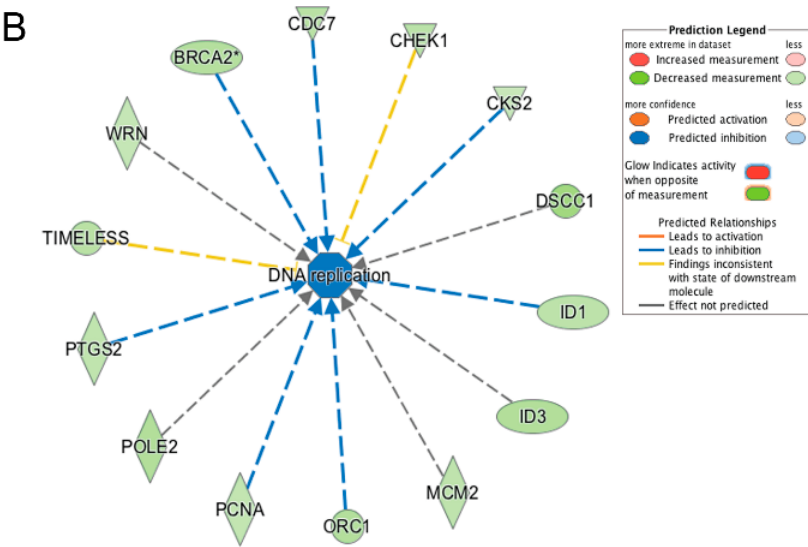
Figure 10. Ingenuity pathway analysis of differentially expressed genes unique to wildtype cells during transition from day 1 to day 2 of differentiation. ( A ) The top canonical pathway enriched from genes differentially expressed only in wildtype cells was the Cell Cycle: G2/M DNA Damage Checkpoint Regulation pathway. The network was generated through the use of IPA (Ingenuity Systems, www.ingenuity.com) on normalized mRNA values. Nodes represent molecules in a pathway, while the biological relationship between nodes is represented by a line (edge). Edges are supported by at least one reference in the Ingenuity Knowledge Base. The intensity of color in a node indicates the degree of up- (red) or down- (green) regulation. Nodes are displayed using shapes that represent the functional class of a gene product (Circle = Other, Nested Circle = Group or Complex, Rhombus = Peptidase, Square = Cytokine, Triangle = Kinase, Vertical ellipse = Transmembrane receptor). Edges are marked with symbols to represent the relationship between nodes (Line only = Binding only, Flat line = inhibits, Solid arrow = Acts on, Solid arrow with flat line = inhibits and acts on, Open circle = leads to, Open arrow = translocates to). ( B ) Biological Function Analysis with IPA on genes differentially expressed only in wildtype cells during transition from day 1 to day 2 of differentiation identified DNA replication ( p -value: <0.05) as the top pathway. The figure represents genes that are associated with a particular biological function that are altered in the uploaded dataset. Genes that are upregulated are displayed within red nodes and those down-regulated are displayed within green nodes. The intensity of the color in a node indicates the degree of up-(red) or down-(green) regulation. The shapes of the nodes reflect the functional class of each gene product: transcriptional regulator (horizontal ellipse), transmembrane receptor (vertical ellipse), enzyme (vertical rhombus), cytokine/growth factor (square), kinase (inverted triangle) and complex/group/other (circle). An orange line indicates predicted upregulation, whereas a blue line indicates predicted downregulation. A yellow line indicates expression being contradictory to the prediction. Gray line indicates that direction of change is not predicted. Solid or broken edges indicate direct or indirect relationship, respectively.